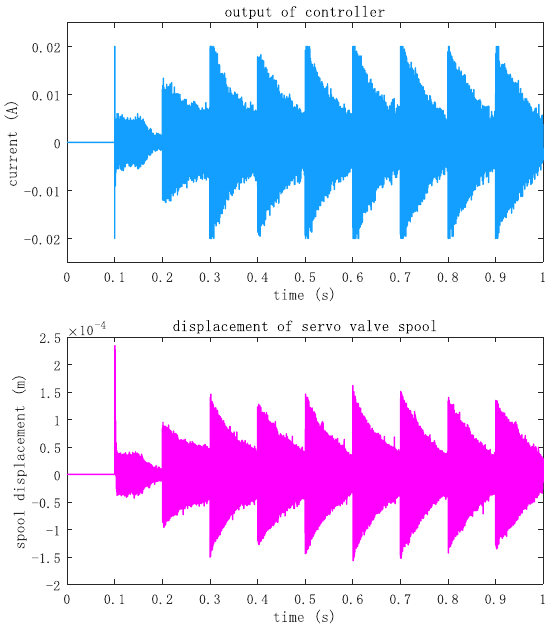
Figure 15. Controller output and spool displacement curve.